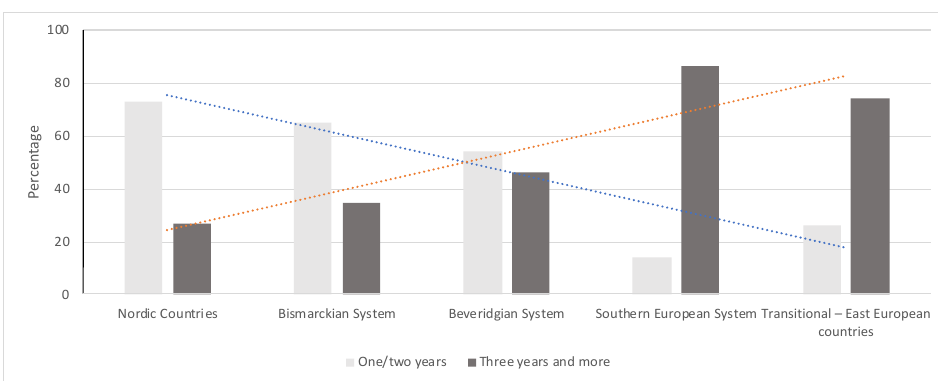
Figure 2. Distribution of the sample by the oral health care system and planning period to own a